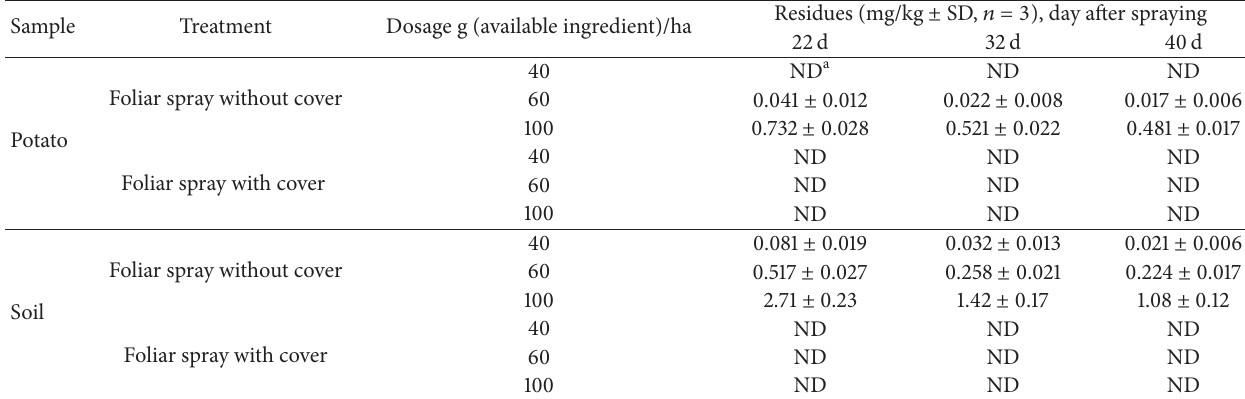
Table 2: Final residues of paclobutrazol in potato and soil.